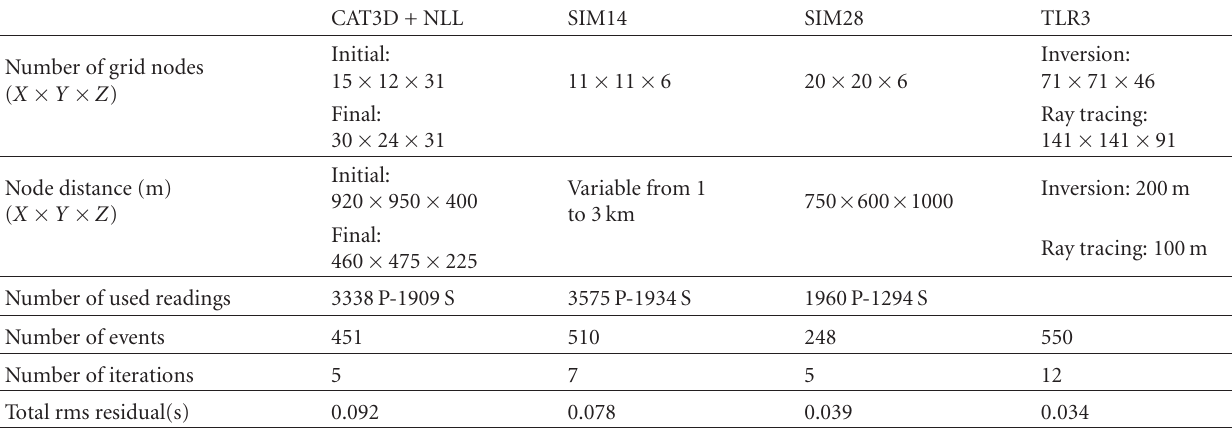
Table 2: Main parametres and settings adopted by the di ff erent methods. CAT3D + NLL